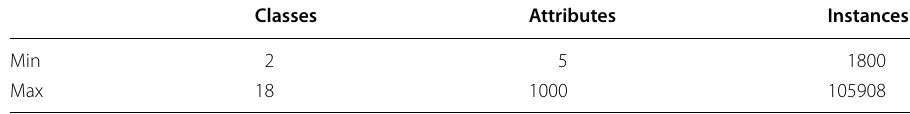
Table 2 Statistics about the used datasets according to the number of classes, predictive attributes and instances